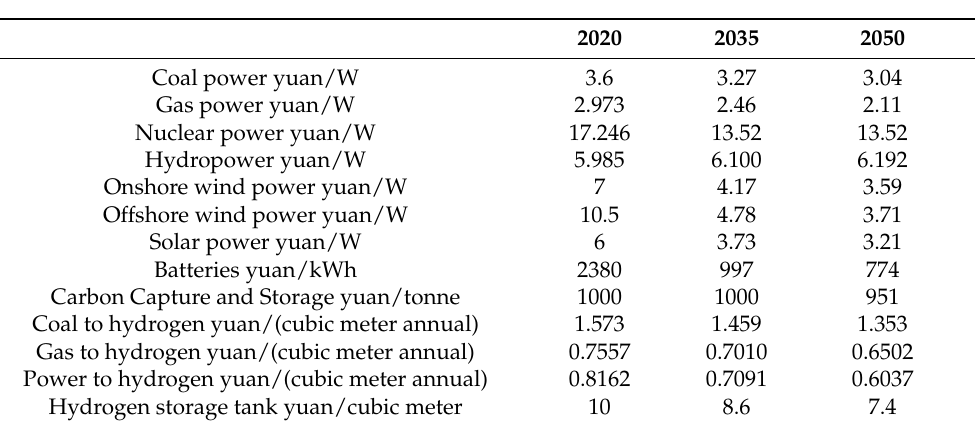
Table A5. Technology costs assumptions